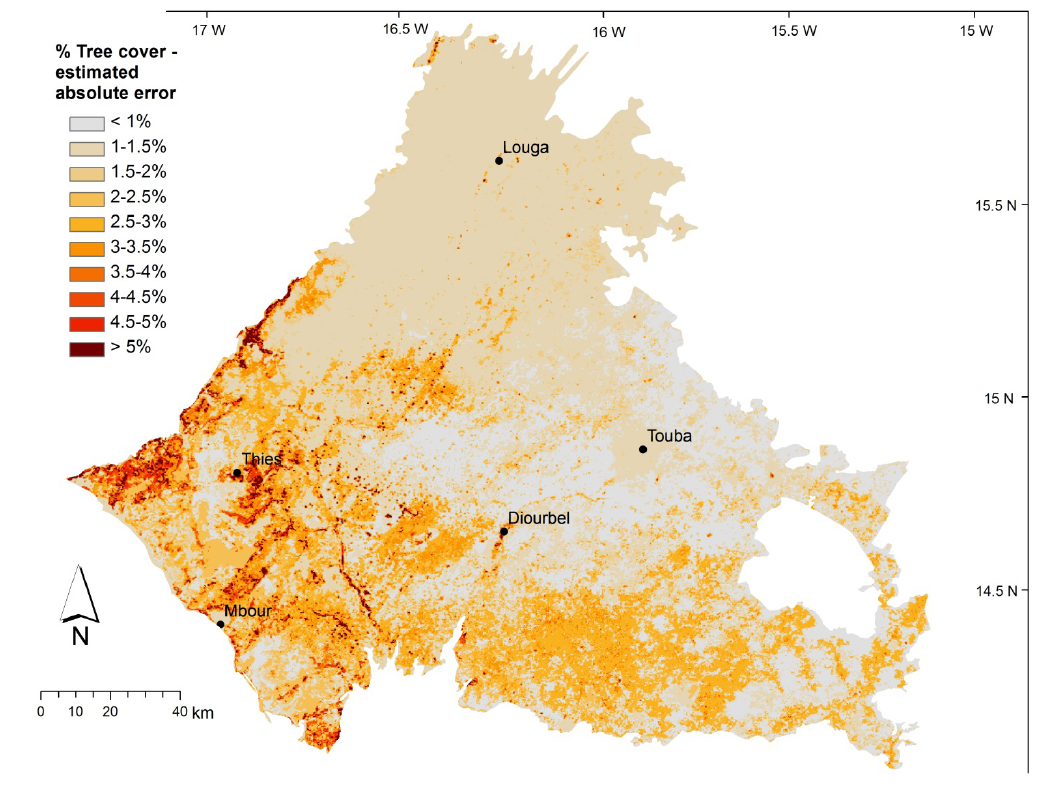
Figure 7. Error map showing the spatial distribution of potential error beyond the area of the reference map. For each pixel, the number represents the difference between the value that is predicted and the value that could exist, based on the estimated error of the rule created from the training data and used to predict the pixel